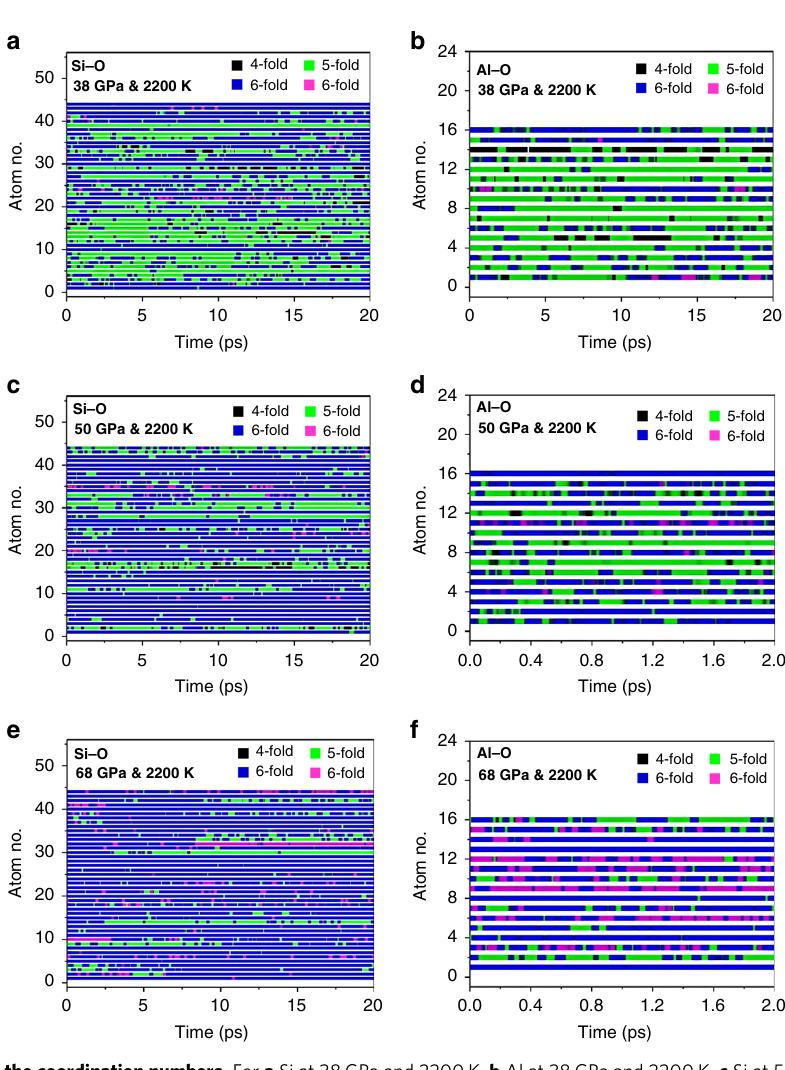
Fig. 2 Temporal evolution of the coordination numbers. For a Si at 38 GPa and 2200 K, b Al at 38 GPa and 2200 K, c Si at 50 GPa and 2200 K, d Al at 50 GPa, and 2200 K, e Si at 68 GPa and 2200 K, and f Al at 68 GPa and 2200 K.